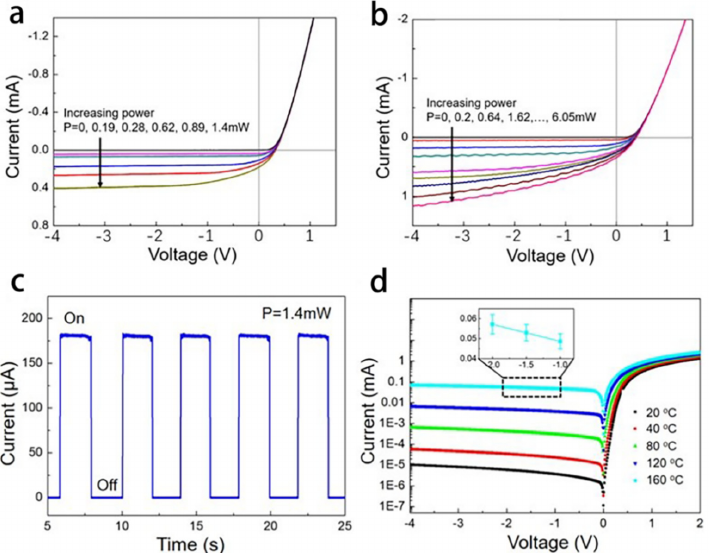
Figure 13. Photoelectric performance test results of in-situ graphene-silicon Schottky sensor. ( a , b ) I-V characteristic curves at different incident light powers. ( a ) White LED light source. ( b ) 792 nm laser light source. ( c ) The light response of the device within five switching periods under the irradiation of a white light source. ( d ) I-V characteristic curves of dark field characteristics of the device at different working temperatures. The illustrations amplify the current of − 2V~ − 1V when the device works at 160 The performance and structure of the Schottky photoelectric sensor constructed by in-situ growth of graphene film are compared with those of graphene-silicon photoelectric